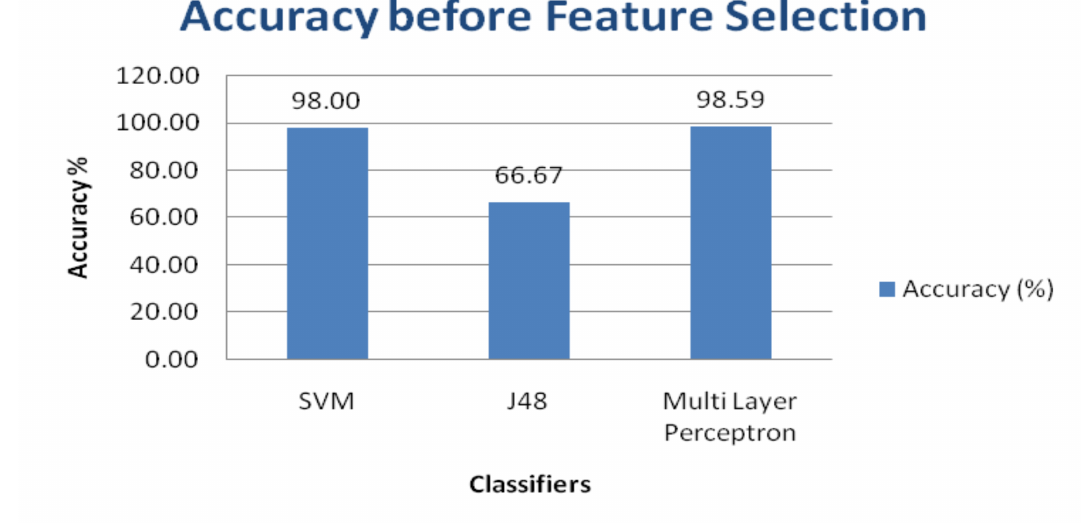
Figure 2. Comparative accuracy of multilayer (ML) classifiers on data after pre-processing.